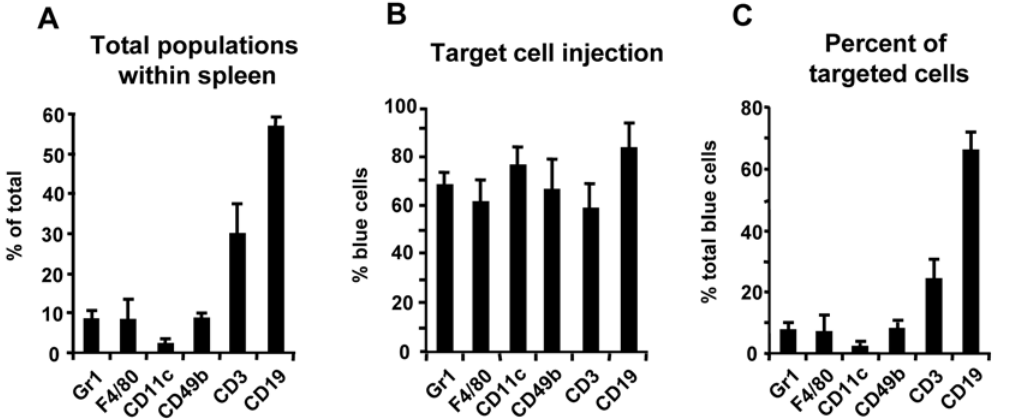
Figure 4. Distribution of Yop injection in cultured splenocytes. Splenocytes were infected with E40-pBla (MOI 50) for 1 h. Subsequently cells were stained with CCF4-AM as well as antibodies against indicated surface markers. (A) Percentage of splenocytes expressing the indicated surface markers. (B) Percentage of blue cells of the indicated subpopulations (C) Percentage of blue cells expressing one of the indicated surface markers. Data are summarized as the mean 6 SD of three independent